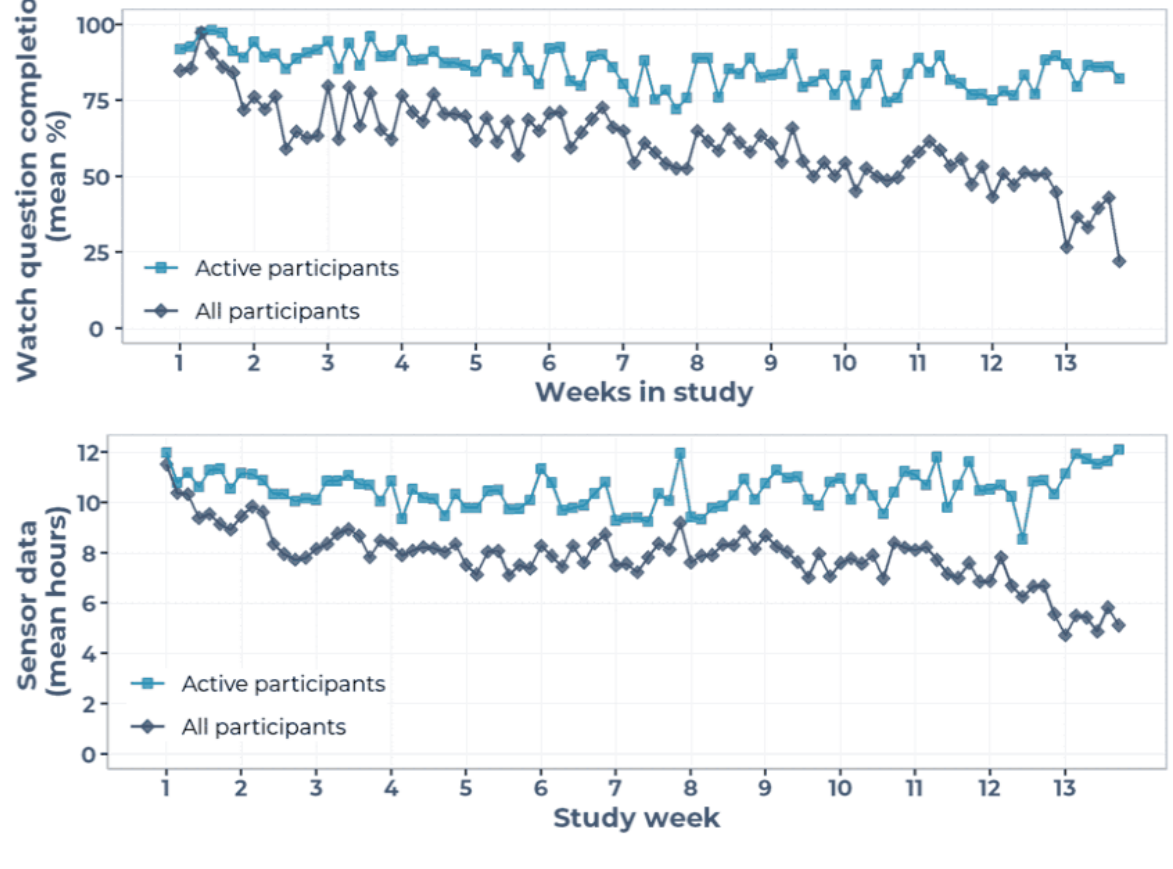
Figure 4. Engagement per study day, showing mean hours of sensor data (lower) and mean watch question completeness (upper). Dark blue diamonds correspond to median over all 26 participants; light blue squares correspond to median over all active